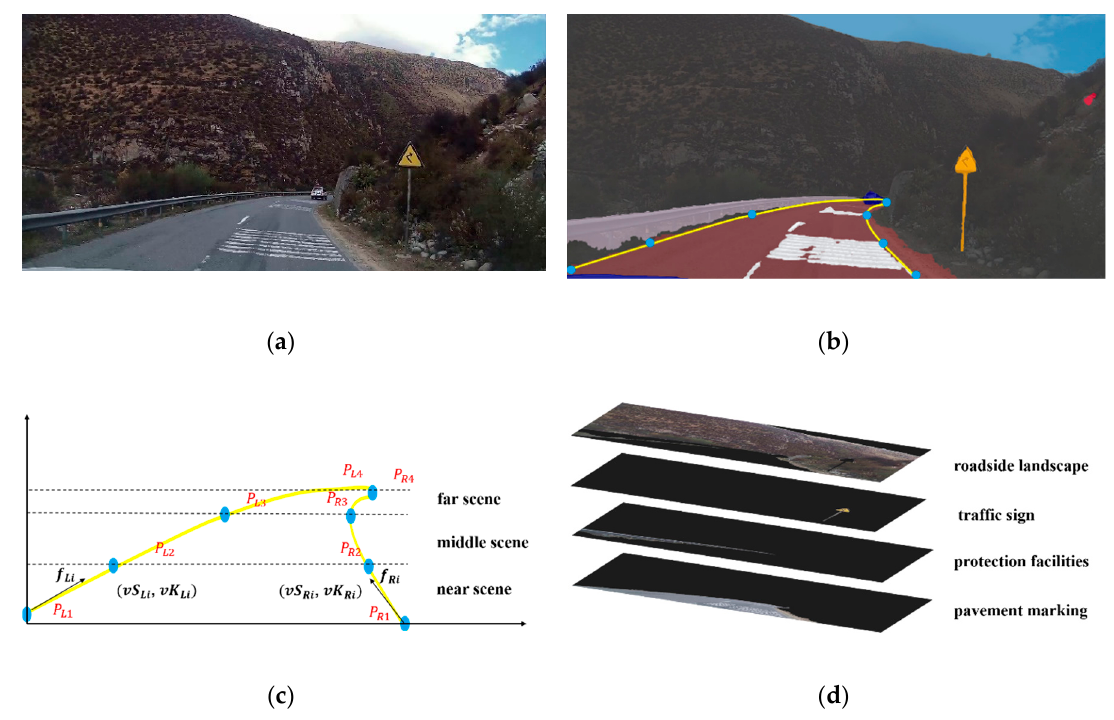
Figure 1. An instance of visual information extraction. ( a ) Original road scenario; ( b ) Lane boundary fitting and semantic segmentation; ( c ) Calculation of shape parameters; ( d ) Extraction of pixels by category.